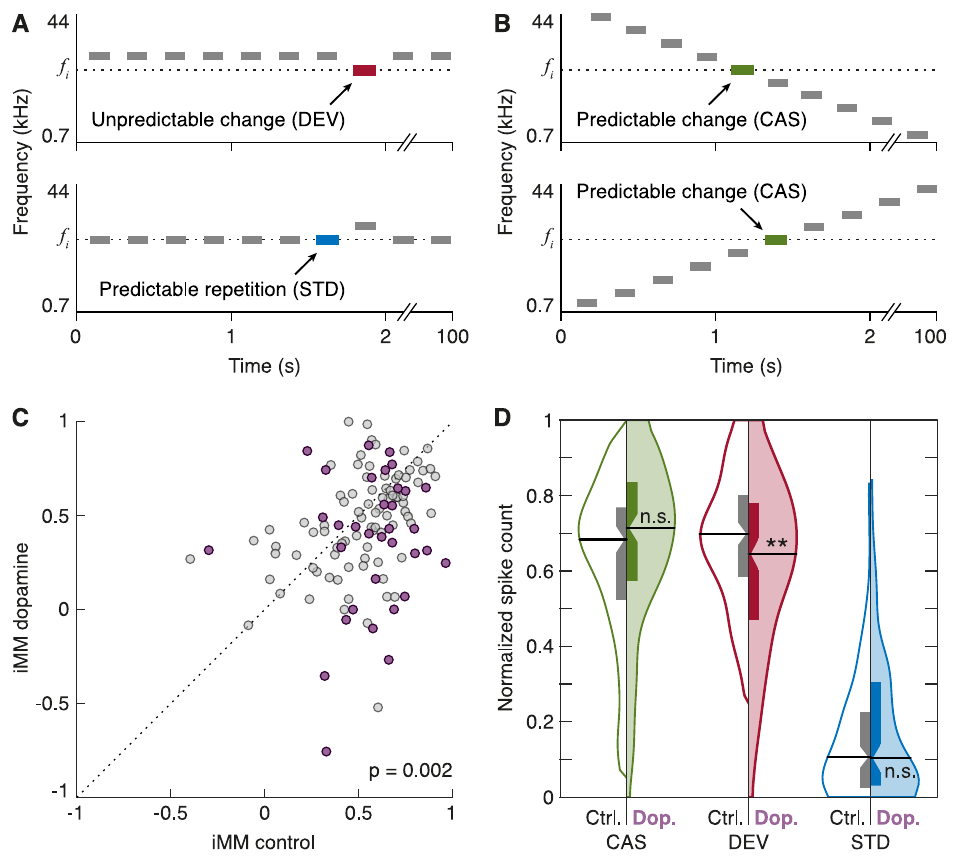
Fig 5. Dopamine effects on unexpected auditory input. (A) Oddball paradigm, displaying 2 experimental conditions for a given f i target tone. (B) CASs highlighting the f i target tone. (C) Scatterplot of the iMM in control condition versus dopamine application. Frequencies that underwent significant iMM changes are represented in purple, whereas the rest are marked as gray dots. (D) Violin plots of the CAS (green), DEV (red), and STD (blue) normalized responses. Control conditions are represented in the left half of each violin (no color), and dopamine effects are on display in the right half (colored). Horizontal thick black lines mark the median of each distribution, and the boxplots inside each distribution indicate the interquartile range, with the confidence interval for the median indicated by the notches. Regarding statistical significance, n.s. indicates that p > 0.05, and �� indicates that p < 0.01 (repeated- measures ANOVA, Dunn–Sˇida´k correction). The underlying data for this figure can be found in S4 Data. CAS, cascade sequence; DEV, deviant condition; FR, firing rate; iMM, index of neuronal mismatch; SFR, spontaneous firing rate; STD, standard condition.